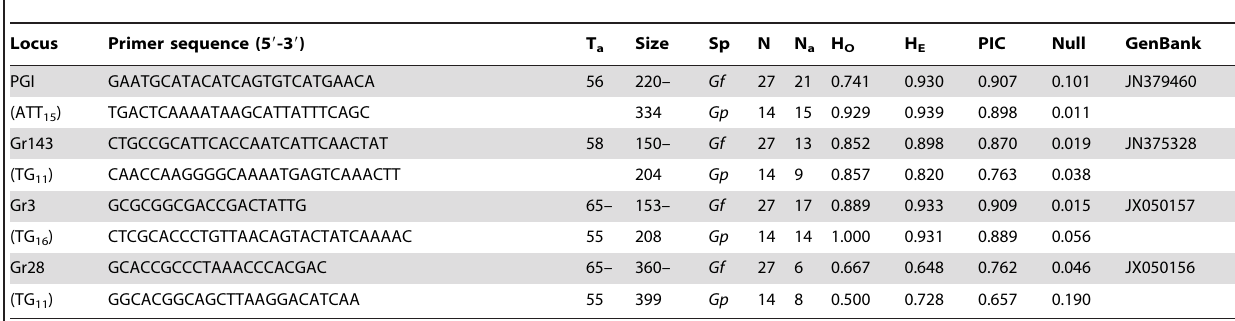
Table 1. Primer sequences and amplification conditions for Gryllus microsatellite loci used in paternity analysis.